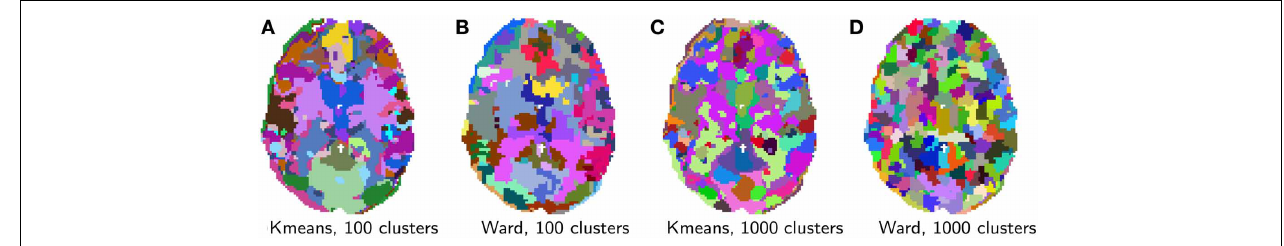
FIGURE 5 | Brain parcellations extracted by clustering. Colors are random. (A) K-means, 100 clusters, (B) Ward, 100 clusters, (C) K-means, 1000 clusters, and (D) Ward, 1000 clusters.